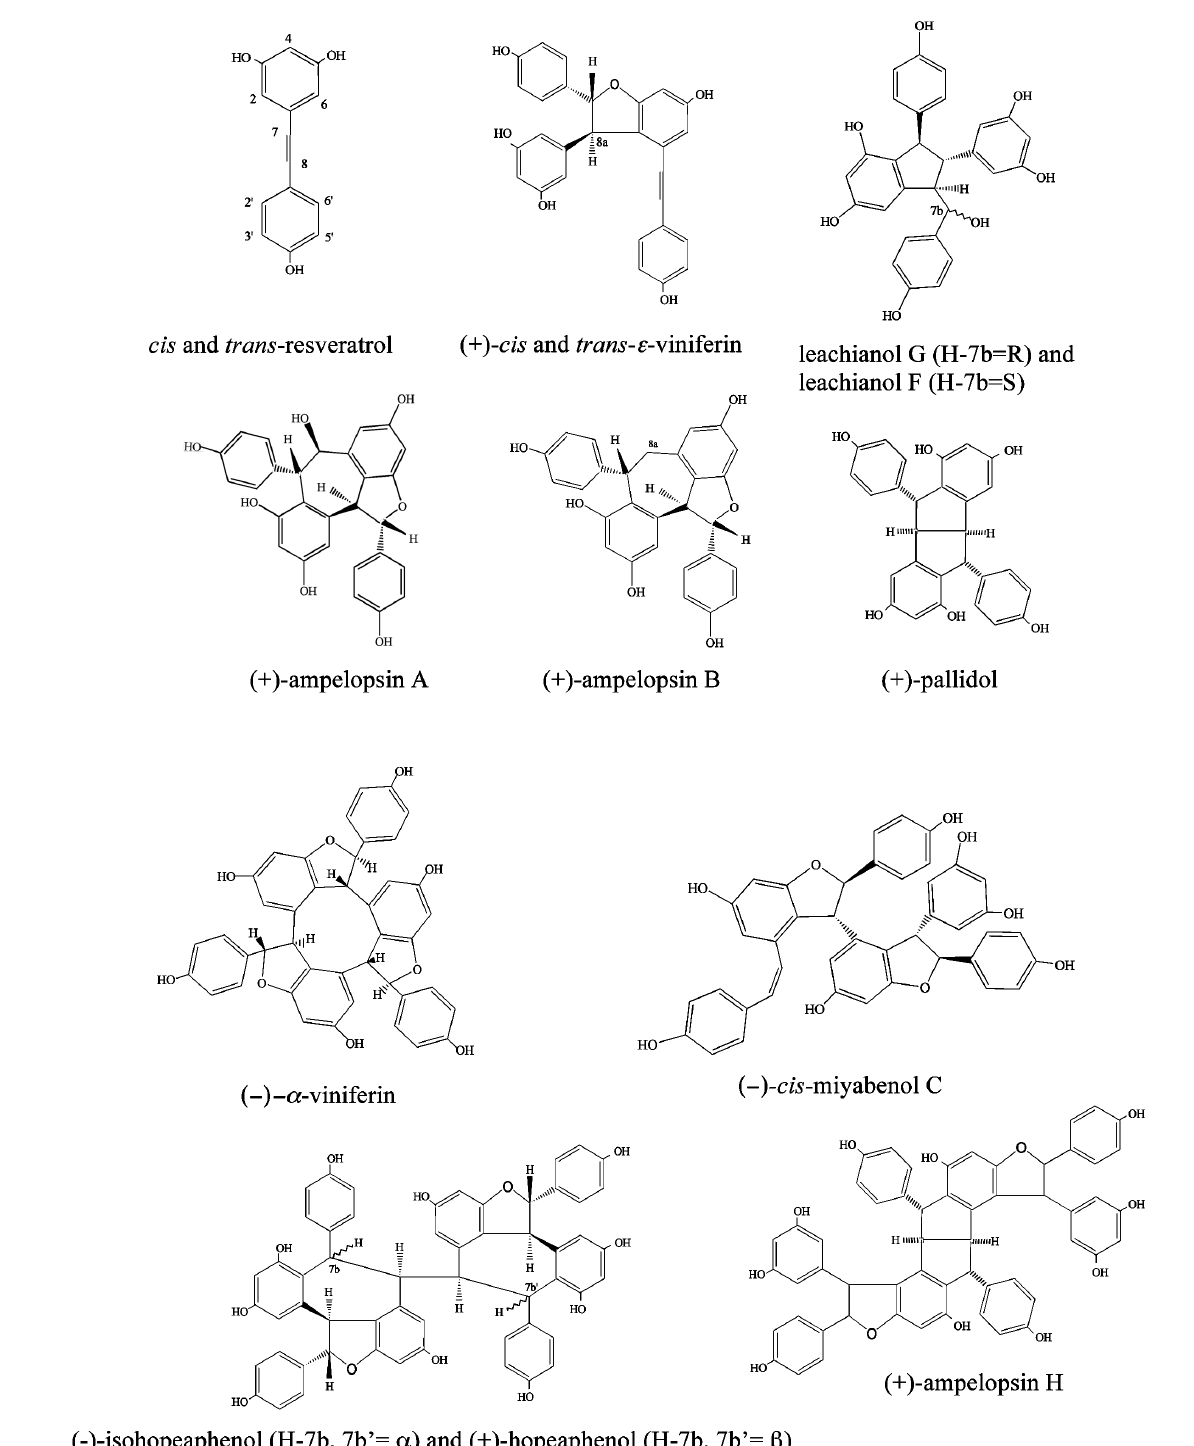
Figure 1. Structures of stilbene polyphenols isolated from wood of Vitis vinifera cv.